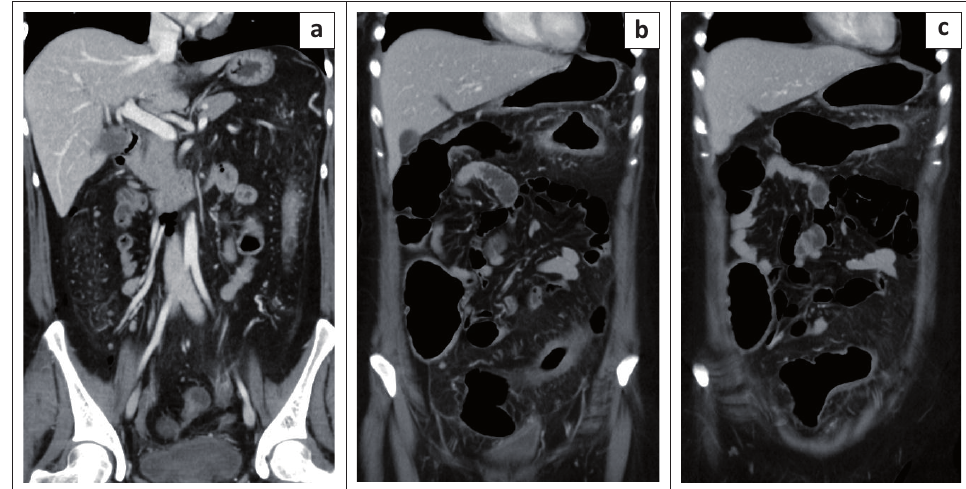
FIGURE 1: Coronal reformat images (a, b and c) of the abdomen in venous phase after intravenous contrast administration.